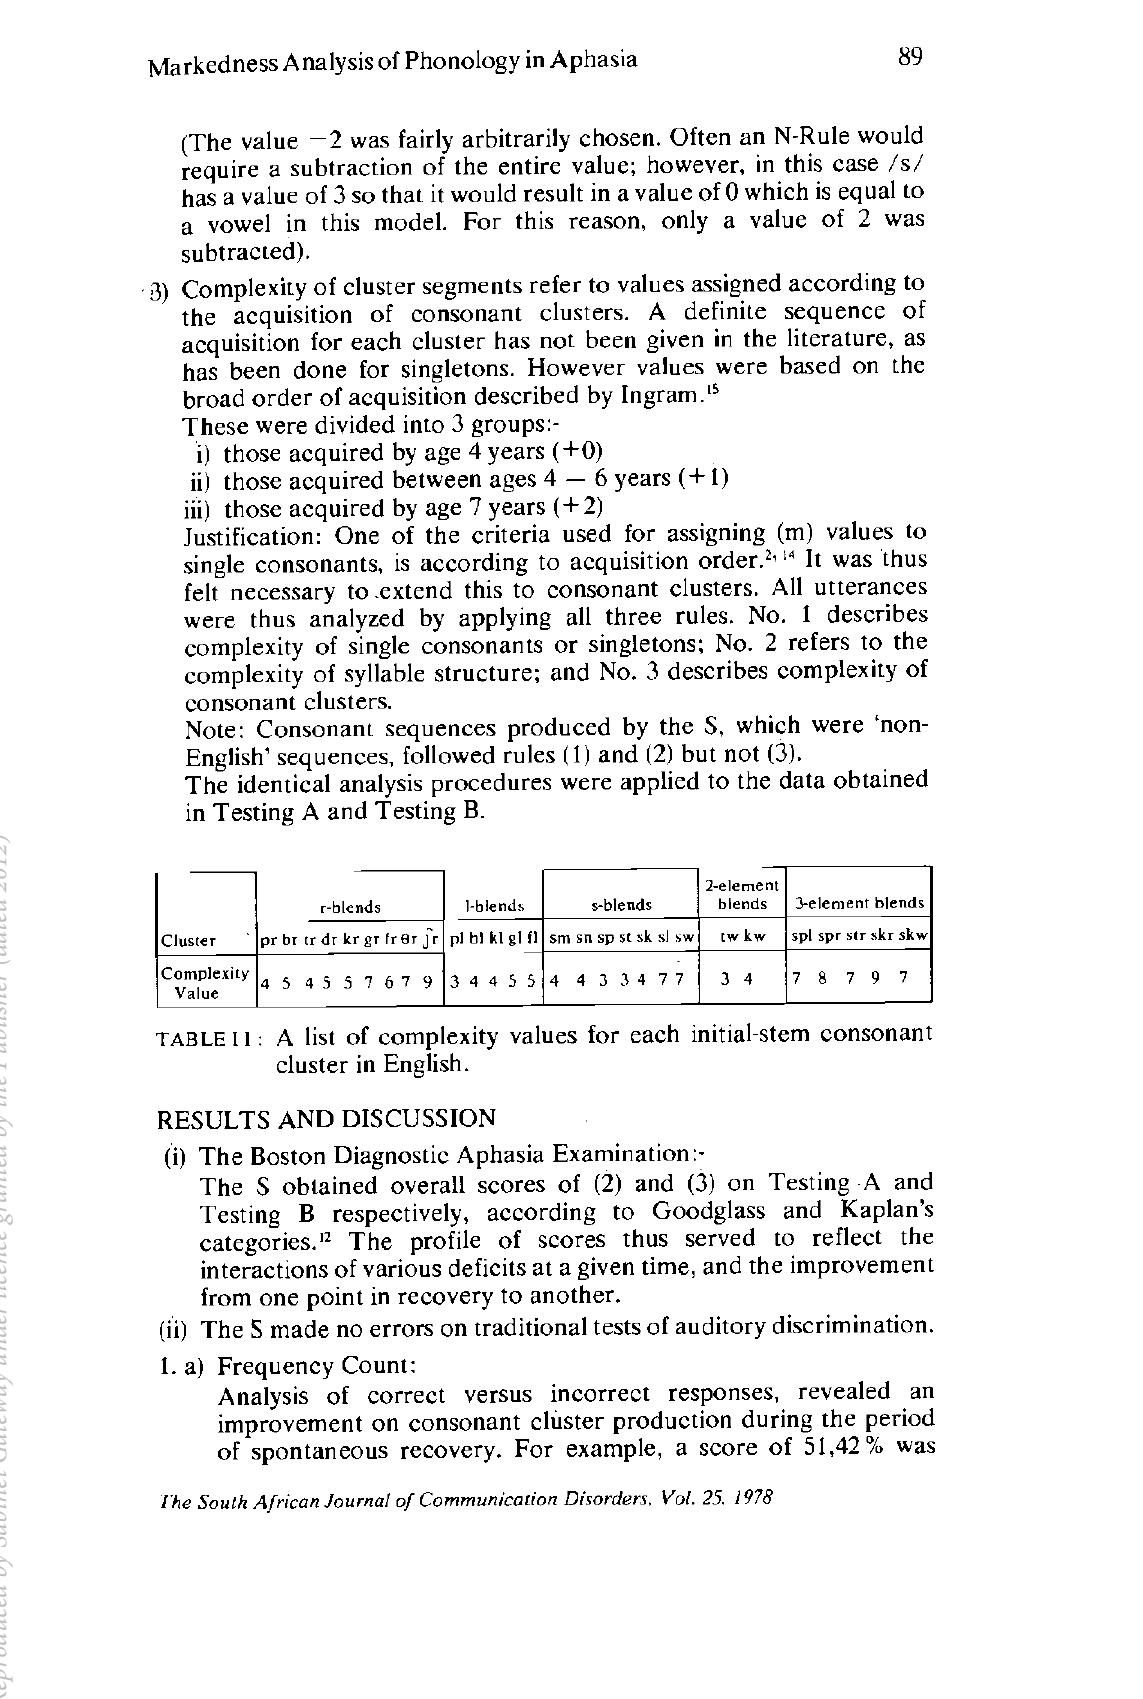
TABLE 11 : A list of complexity values for each initial-stem consonant cluster in